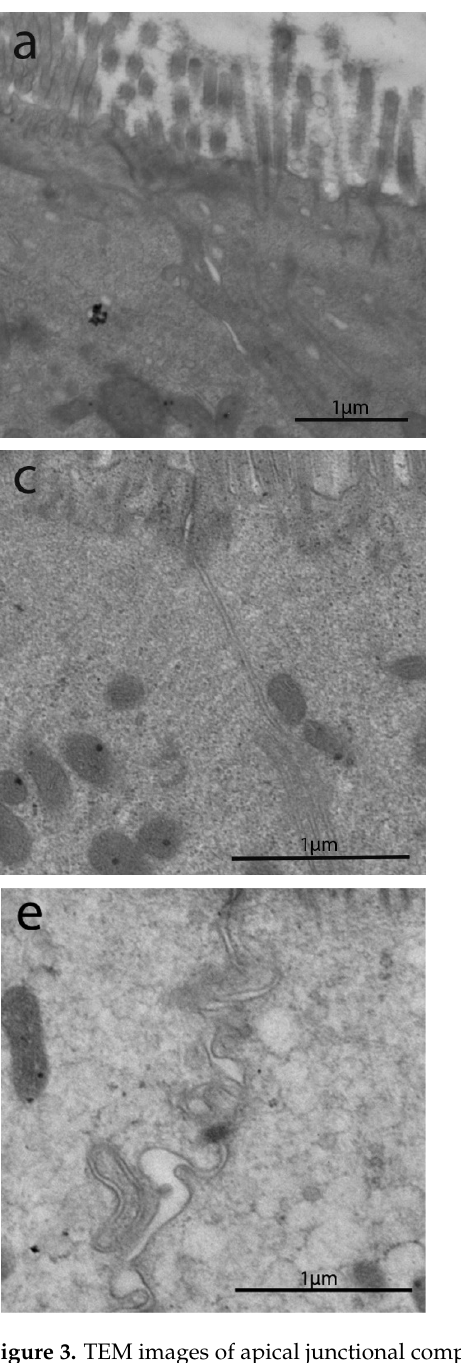
in the apical enterocytes portion in NCGS (Figure 6b) and Ni ACM patients (Groups D and E). (Figure 6d), and Ni ACM patients.